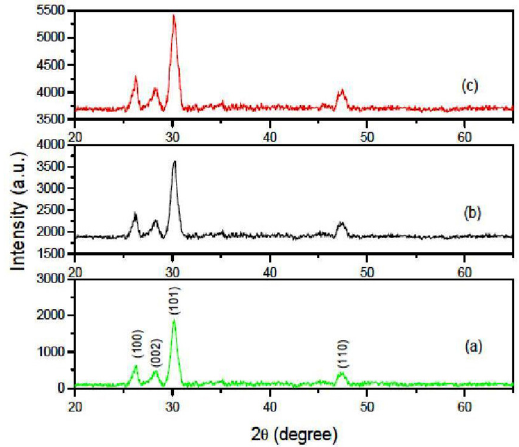
Figure 1: X-ray diffraction pattern of (a) ZnS , (b) 2.5% Sn: ZnS and (c) 5% Sn: ZnS.